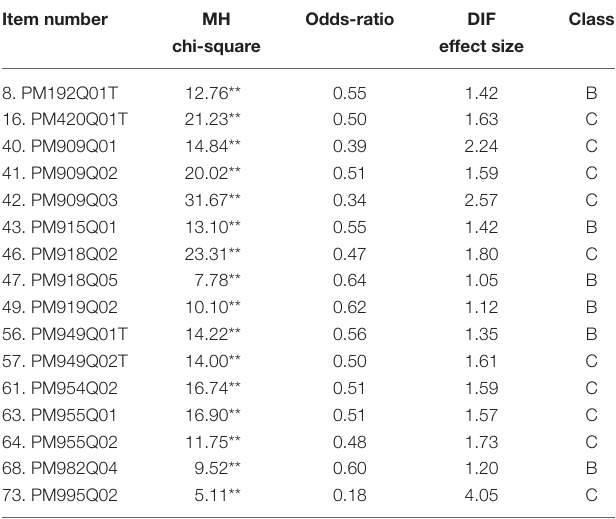
TABLE 2 | Summary results from the MH procedure to identify DIF effects.